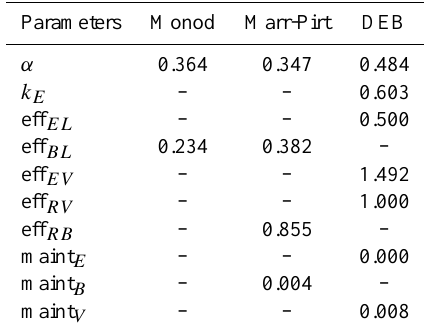
Table 2. Parameter values for each of the three models for exper- iment SA. POC and DOC data were corrected for bacteria passing through the filters. Parameters were estimated by the minimisa- tion of the sum of squared deviations of model predictions to data points. As the Monod model cannot produce any release of non- labile material, DOC concentrations were modified by subtracting the R-DOC concentration at the end of the experiment from each DOC data point.